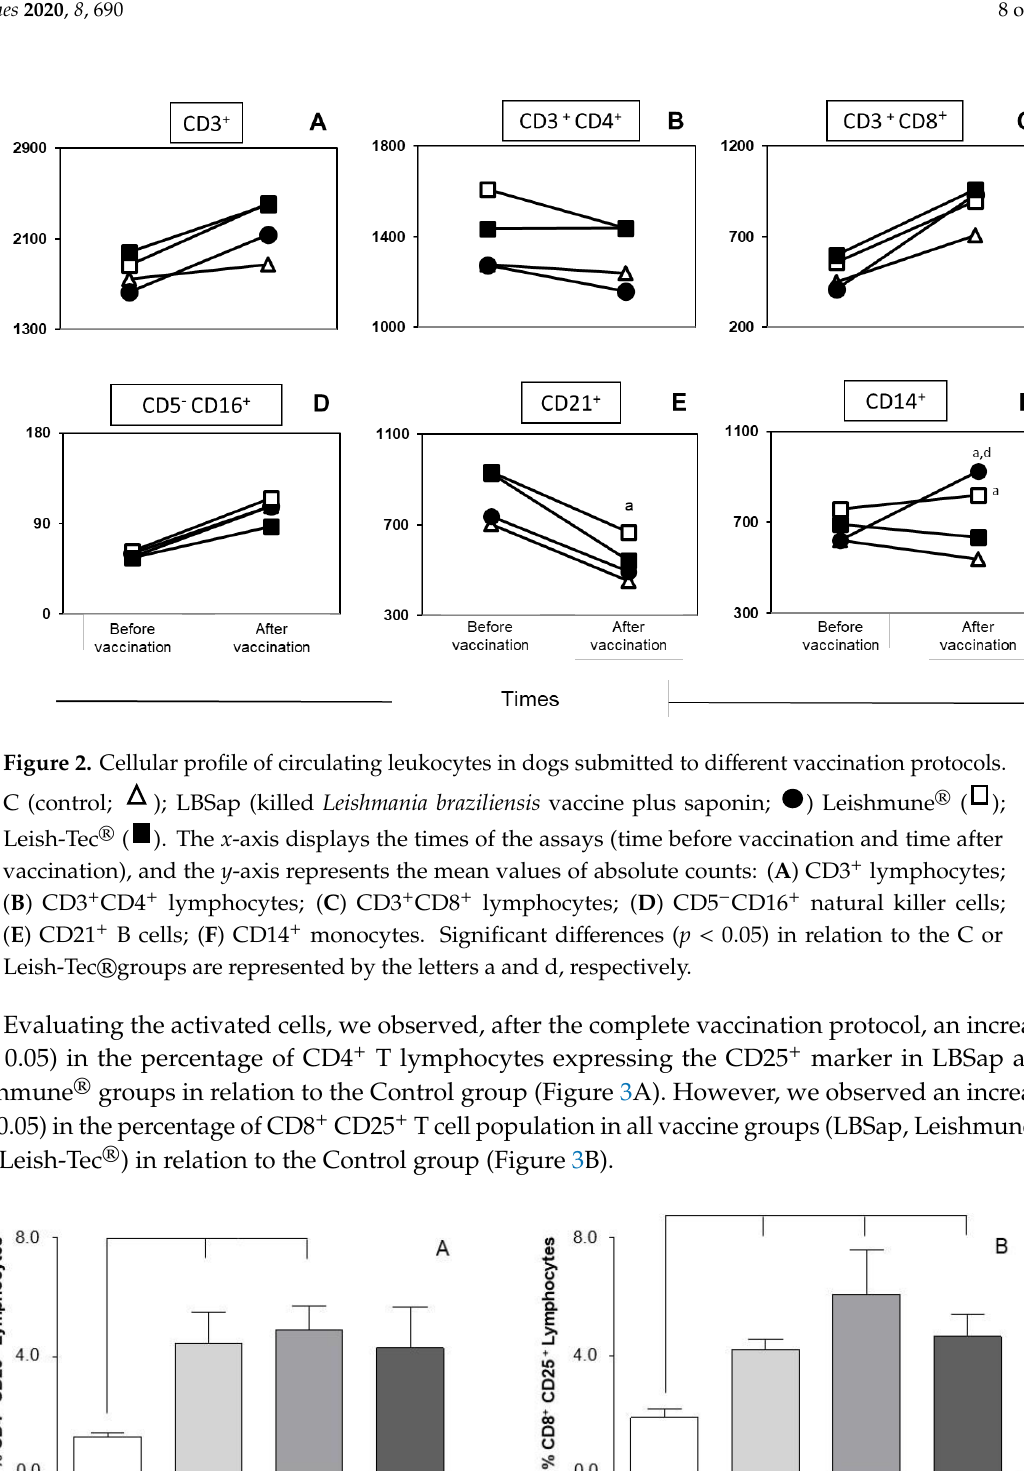
Figure 3. Cellular profile of circulating regulatory T lymphocytes in dogs submitted to different vaccination protocols. The x -axis displays the groups: C (control; ); LBSap (killed L. braziliensis vaccine plus saponin; ); Leishmune ® ( ); Leish-Tec ® ( ). The y -axis represents the mean values of percentage counts of ( A ) CD4 + CD25 + lymphocytes and ( B ) CD8 + CD25 + lymphocytes at the time after vaccination. Significant differences ( p < 0.05) between the C group and the LBSap, Leishmune ® , and Leish-Tec ® groups are indicated by connecting lines.